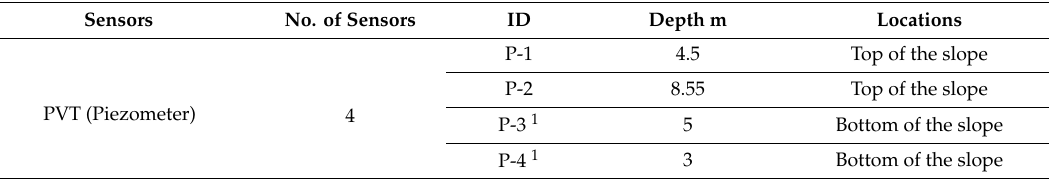
Table 3. Planning of sensors on the slope at Øysand.